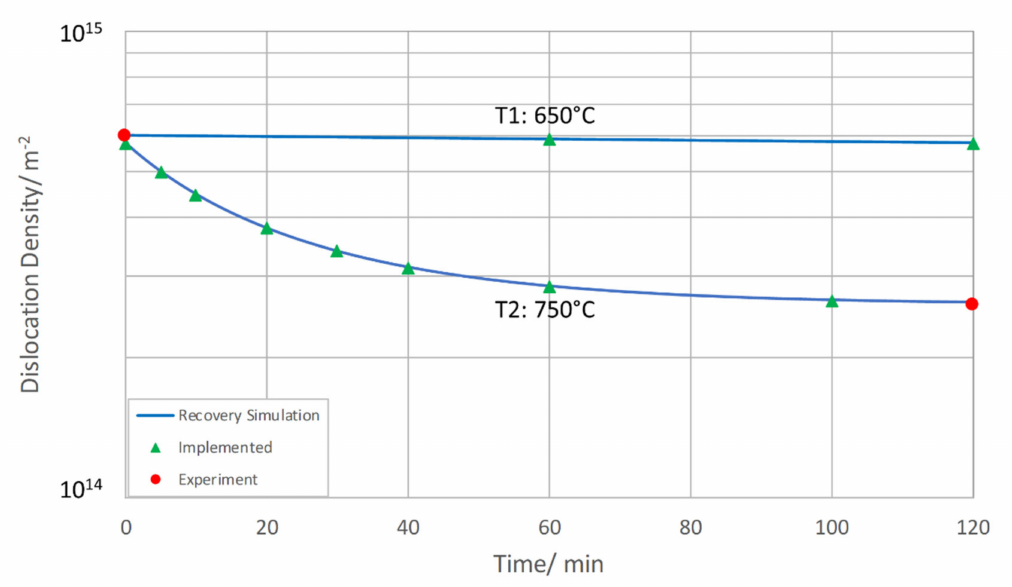
Figure 8. Simulated static recovery during tempering at 650 ◦ C (T1) and 750 ◦ C (T2). During ageing, static recovery was simulated in the same way, and was incorporated stepwise into MatCalc and calibrated again by our TEM data in as-received condition (N + T) as well as after 1000 h of ageing at 700 ◦ C (see Figure 9).